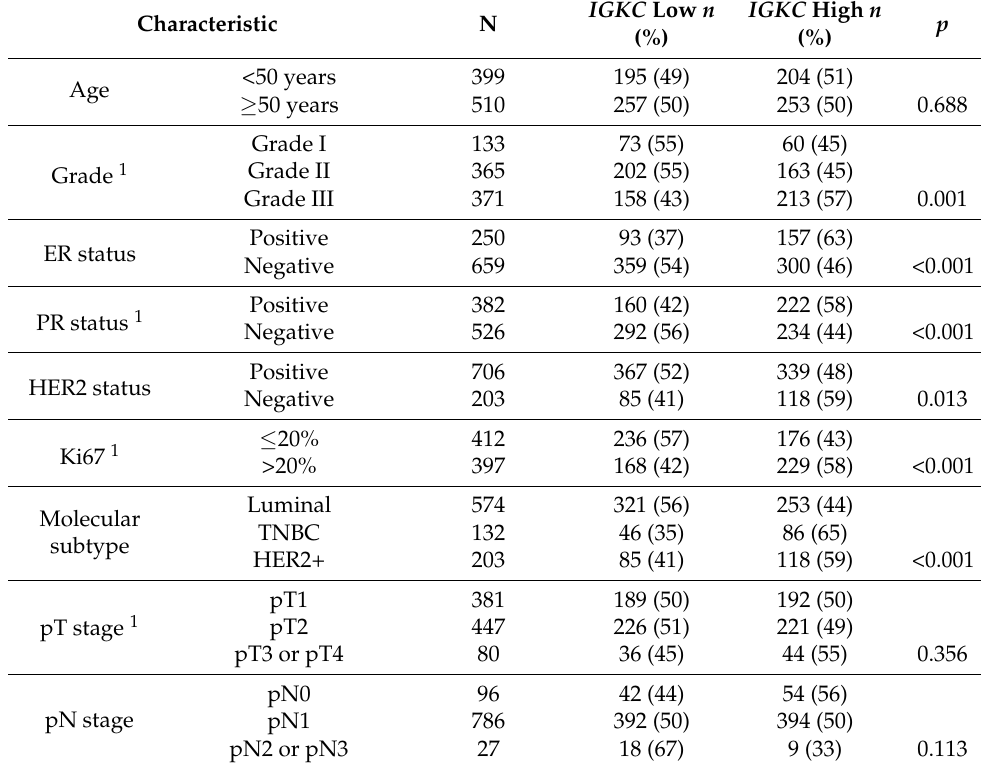
receptor; HER2, human epidermal growth factor receptor 2; TNBC, triple negative breast